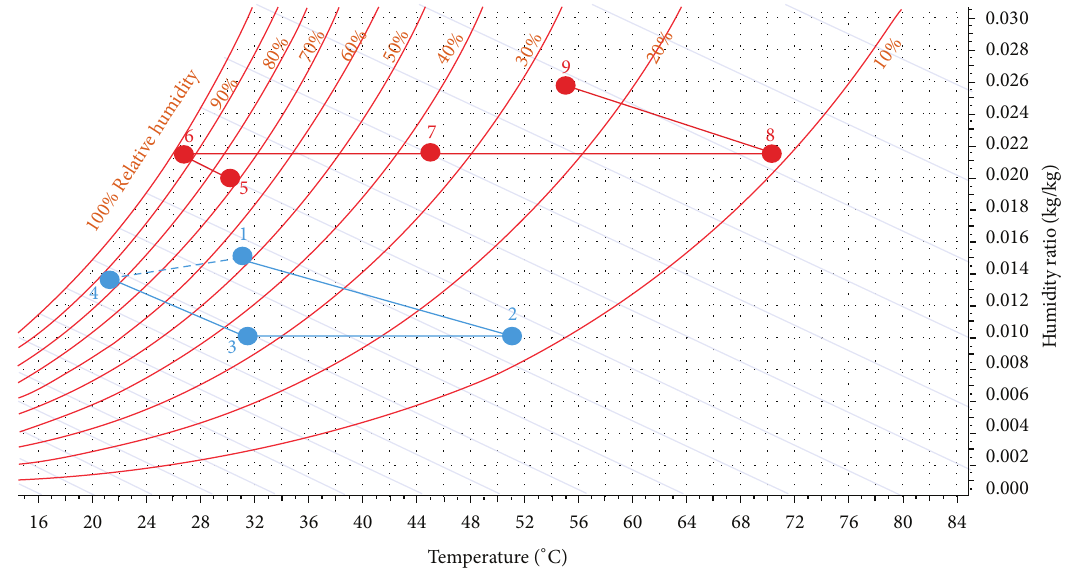
Figure 10: Psychometric chart of one-stage solar desiccant cooling system in recirculation mode.